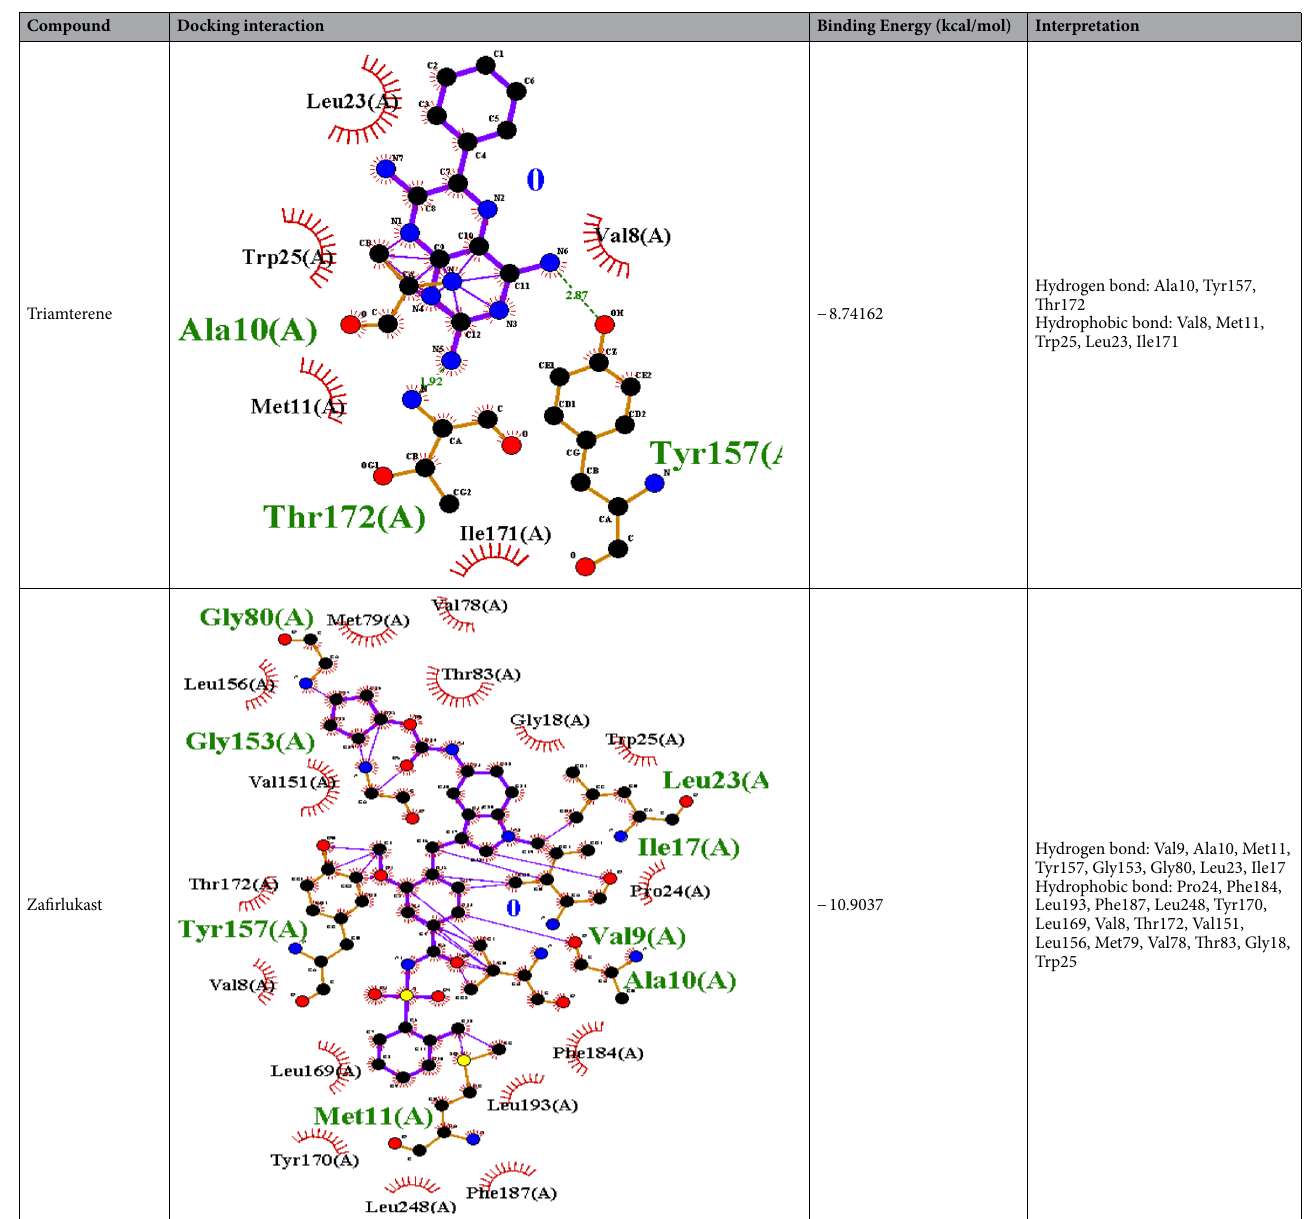
Table 1. Summary of the best docking interactions of the FDA-approved drugs against the TgDHFR protein. Interactions were analyzed and visualized using LigPlot + v.1.4.5.